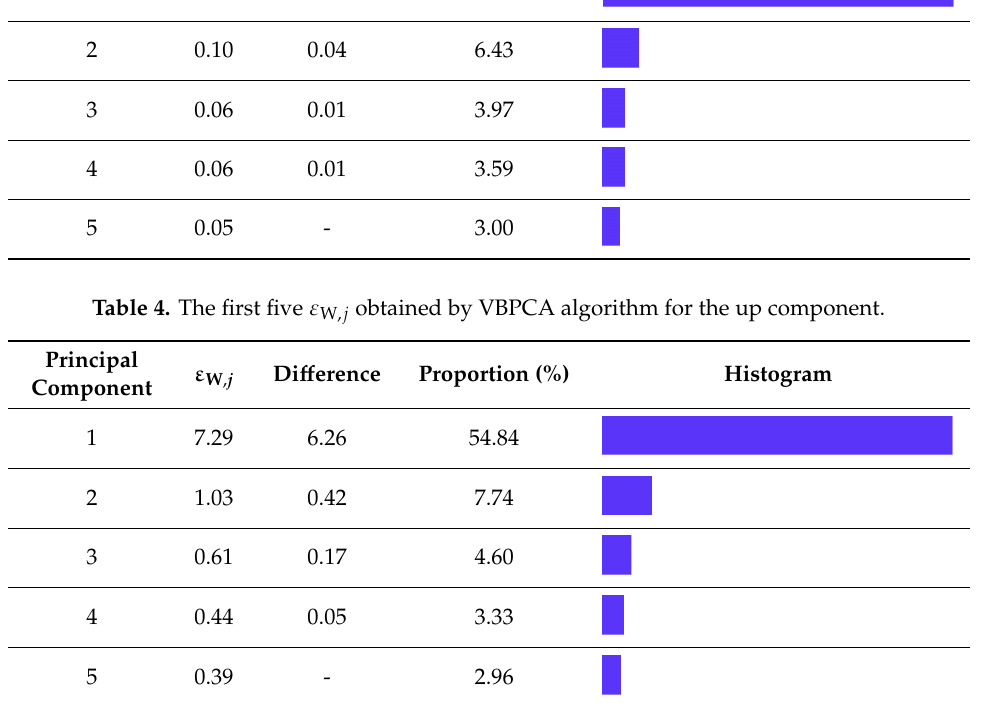
Table 3. The first five ε W, j obtained by VBPCA algorithm for the east component. Table 3. The first five Table 3. The first five obtained by VBPCA algorithm for the east component. Table 3. The first five obtained by VBPCA algorithm for the east component. Table 3. The first five obtained by VBPCA algorithm for the east component. Table 3. The first five obtained by VBPCA algorithm for the east component.